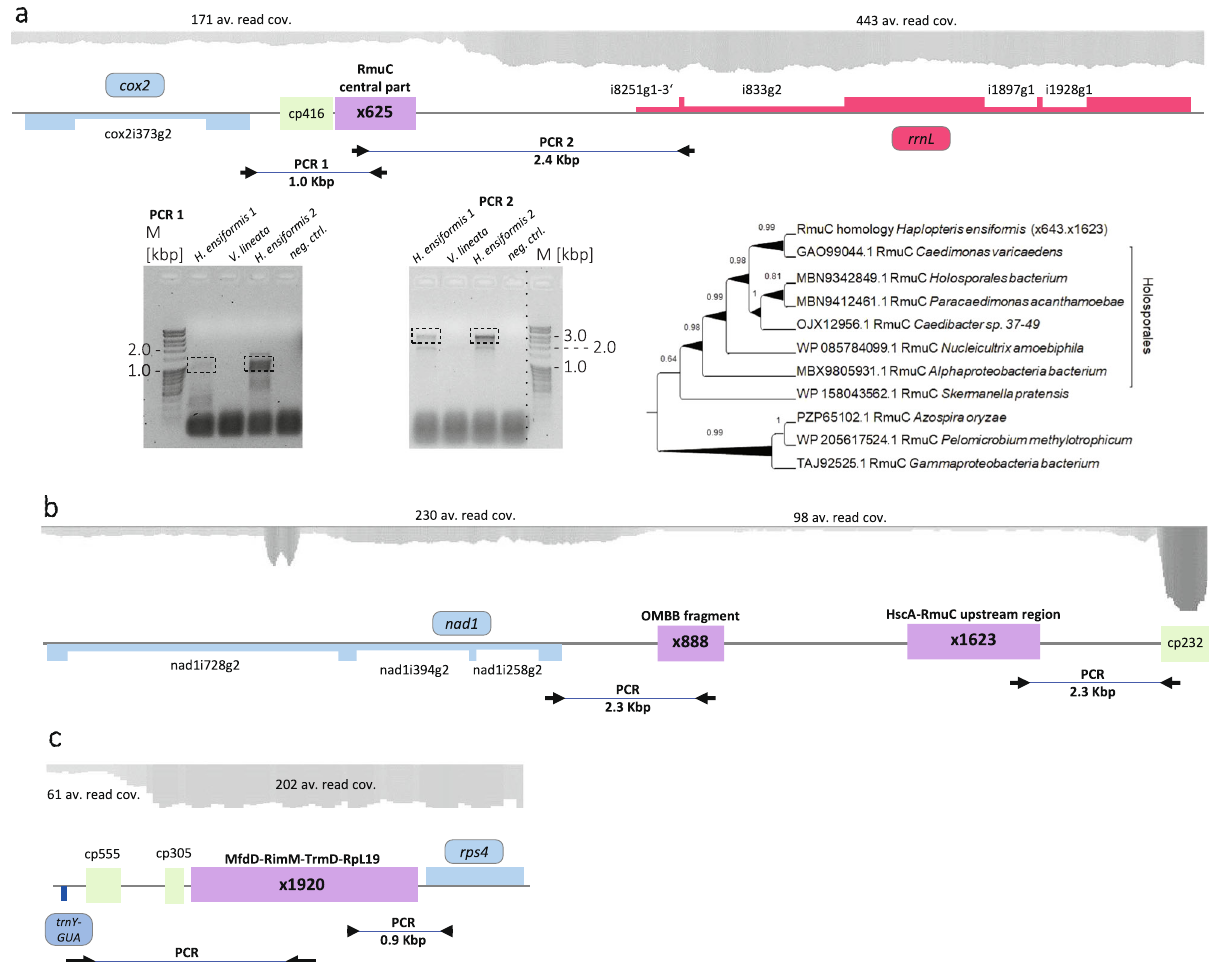
Fig. 7 Rickettsial-like bacterial inserts in the Haplopteris ensiformis mitogenome. Numerous inserts of bacterial, mostly rickettsial, protein-coding sequences were found to be integrated into the Haplopteris ensiformis mitogenome. Xenologous bacterial inserts were annotated to indicate their sizes in base pairs, preceded by “ x ” (see Supplementary Data 3), here showing examples for x625 ( a ), x888 and x1623 ( b ) and x1920 ( c ). Average read coverages are shown on top and PCR amplicons used to verify the mitogenome assemblies are indicated, with PCR results exemplarily shown for x625. a Bacterial insert x625 is located next to cpDNA insert cp416 between cox2 and the downstream part of rrnL . Two overlapping PCRs con fi rm the mitogenome assembly with linkages into both genes for two independent samples from distantly grown Haplopteris ensiformis plant isolations but failed to fi nd products for a Vittaria lineata sample growing near H. ensiformis isolate 1. PCR products of expected sizes (framed with stippled boxes) were cut out and sequenced and con fi rmed sequence identity with the mitogenome assembly. The graph on top shows a continuity for the average read coverages of ca. 170× for cox2 , cp416 and x625 with an increase to ca. 440× for the downstream rrnL region. Insert x625 carries the central region for DNA recombination protein RmuC with the upstream part located on insert x1623. b Xenologous inserts x888 and x1623 are located between nad1 and cpDNA insert cp232. Coding regions for HscA, an FeS-protein assembly chaperone and for RmuC borne on x1623 (see Supplementary Data 3 and Supplementary Data 4) are truncated, but highly conserved in primary sequence as exemplarily shown in the phylogenetic analysis for RmuC documenting a close association with Caedimonas varicaedens . Severely degenerated coding sequences for OMBB, an outer membrane beta-barrel domain containing protein borne on x888 are highly degenerated and do not allow a clear af fi liation with a speci fi c Rickettsiales bacterium. c Xenologous insert x1920 represents a continuous stretch of Rickettsia DNA with top similarities to four coding sequences in Caedimonas spp. Coding sequences (see Supplementary Data 4) are full-length for ribosome maturation factor RimM and the tRNA guanine-methyltransferase TrmD but amino-terminally truncated for MfdD, a transcription-repair- coupling factor and carboxy-terminally truncated for RpL19 encoding protein 19 of the large ribosomal subunit, respectively. The marker lane of the electrophoresis gel covering x625 PCR 2 has been rearranged as indicated by the dotted line. The original images of electrophoretic gels used in this fi gure are deposited as Supplementary Fig. 5c,